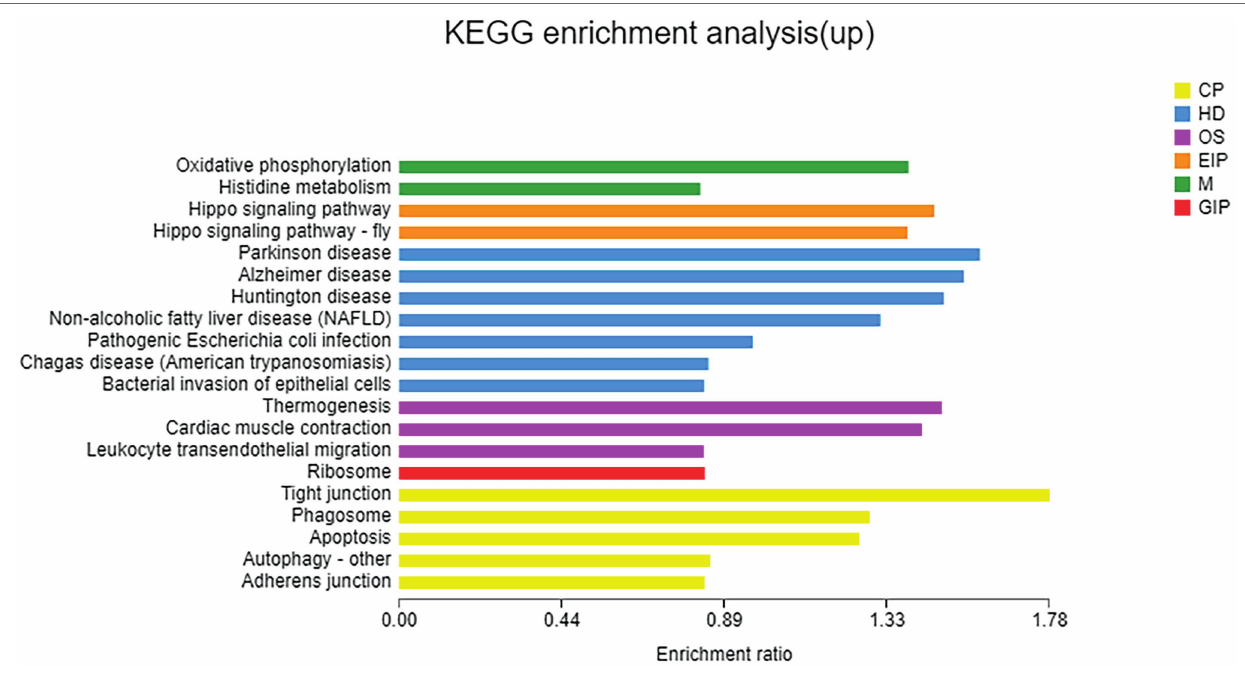
FIGURE 5 | KEGG enrichment analysis of upregulated genes. X-axis, enrichment ratio; Y-axis, functional